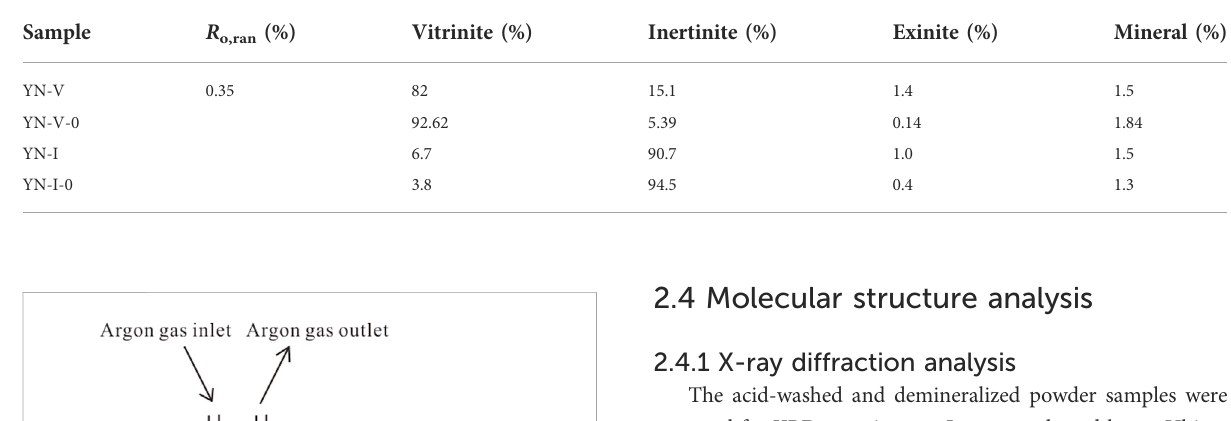
TABLE 1 Petrographic characteristics of initial coal samples and precursor samples of thermal simulation experiments.